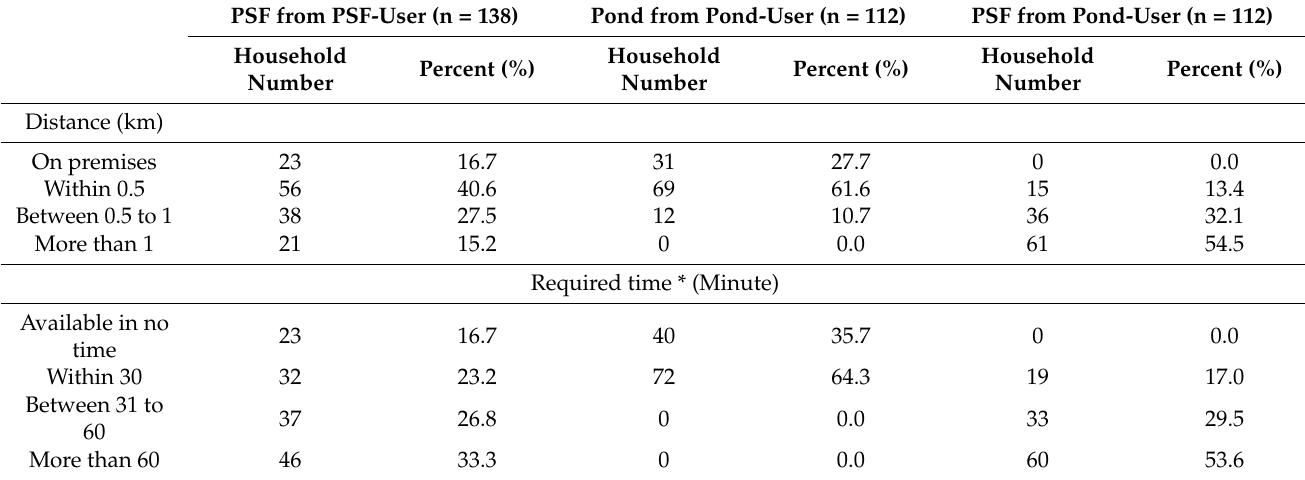
Table 4. Time and distance difficulties to fetch water in Southkhali